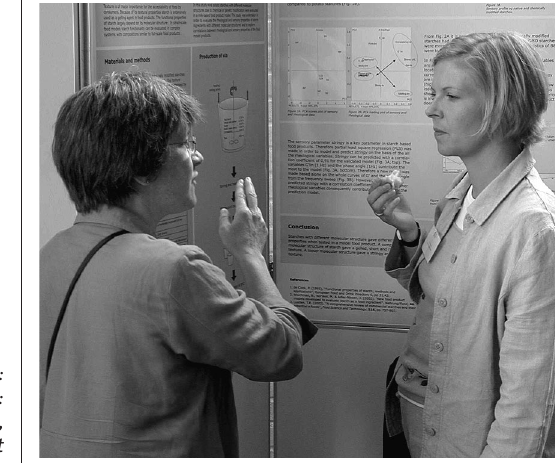
Figure 3: from left to